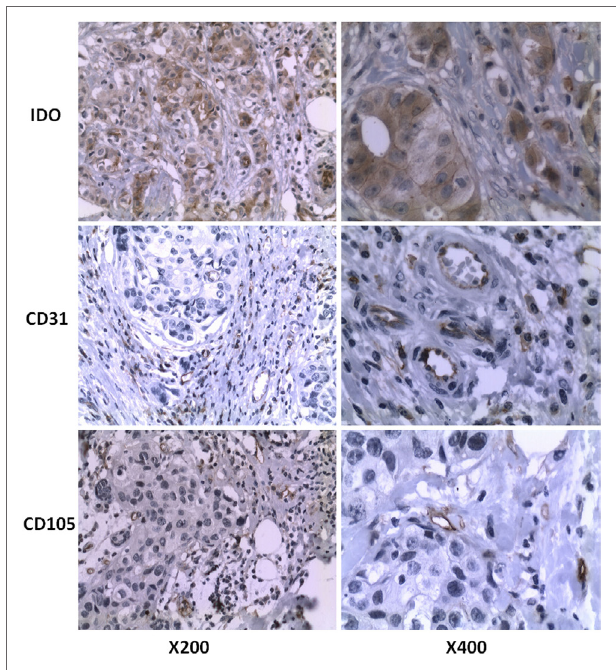
FigUre 1 | IDO, CD31, and CD105 protein expression of breast cancer tissues were assessed by immunohistochemistry. Formalin-fixed and paraffin-embedded sections were stained using the murine monoclonal antibody against human IDO. Original magnification, × 200 and × 400,